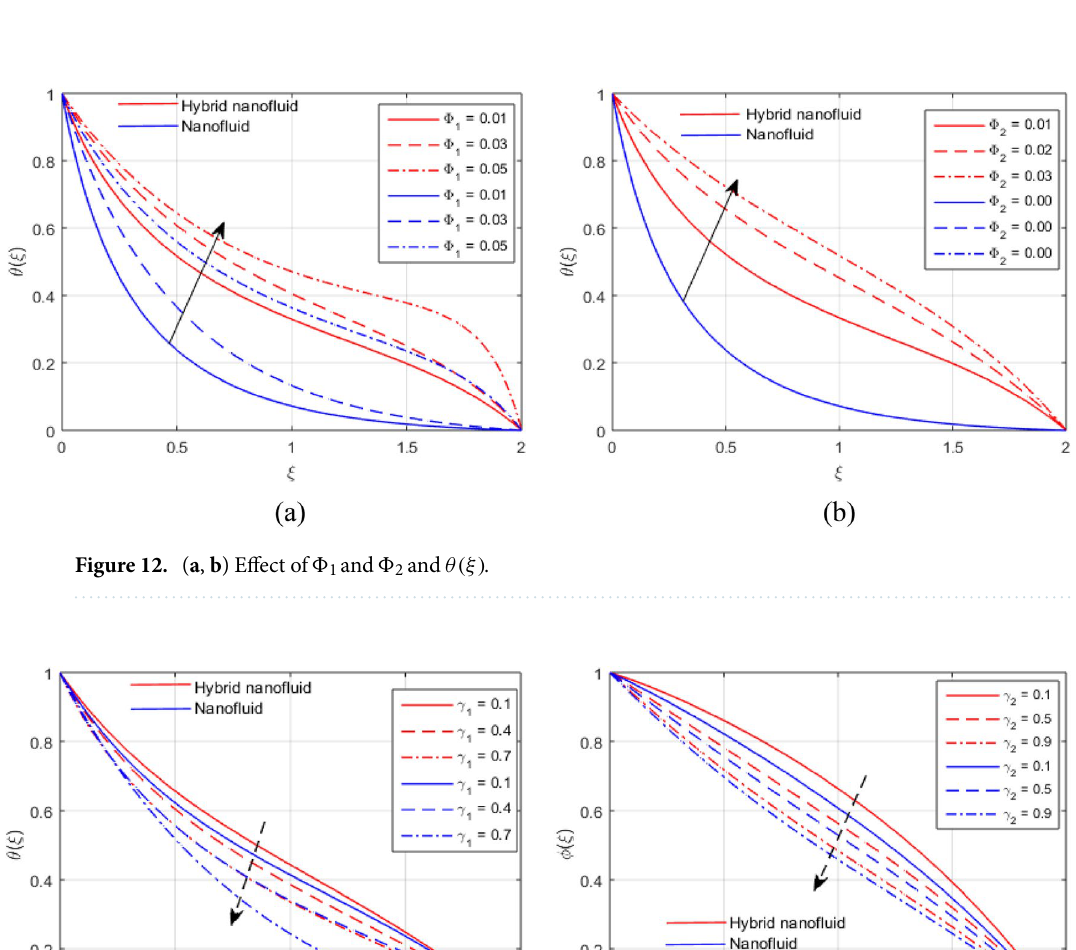
Figure 11. ( a , b ) Influence of A ∗ and B ∗ on θ(ξ) .